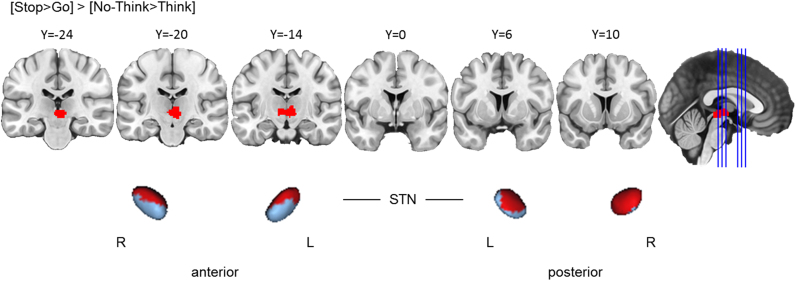
Action cancellation engaged STN more reliably than memory inhibition. Top row: Clusters are presented on coronal slices of a high-resolution MNI atlas. Reference lines for the coronal slices are presented in the sagittal plane. Bottom row: Clusters are displayed on high-resolution parcellaions of the subthalamic nucleus (STN). The contrast analysis was computed using the thresholded ALE images from the individual analyses. All clusters are thresholded at uncorrected p<.001, with the p-value permutations of 10,000 iterations, and the minimum cluster volume of 200 mm3.